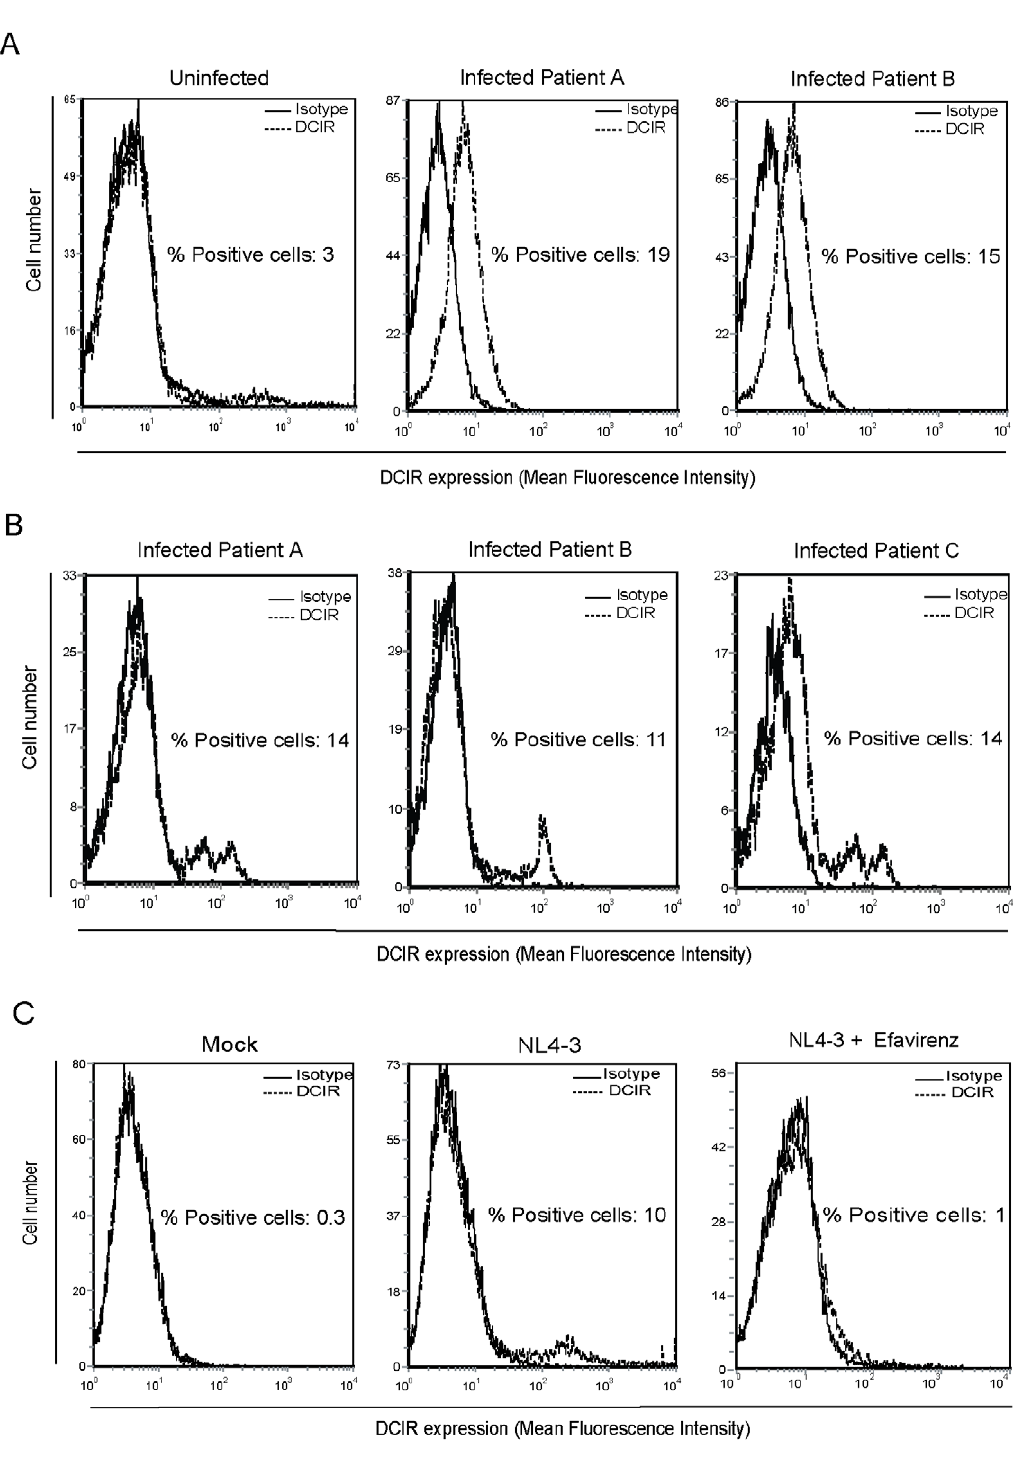
Figure 1. HIV-1 induces DCIR expression in CD4 + T cells under both invivo and invitro conditions. Purified CD4 + T cells were isolated from uninfected healthy donors and two HIV-1-infected aviremic/treated persons (P , 0.05) (A) or three viremic/treatment-naive patients (P , 0.001) (B). Next, cells (1 6 10 6 ) were stained with the R-PE-labeled anti-DCIR monoclonal Ab. Expression of DCIR is shown as a dotted line, whereas the continuous line represents staining obtained with an isotype-matched irrelevant control Ab. For uninfected healthy donors, data shown correspond to a single experiment representative of 5 distinct donors. (C) Purified human primary CD4 + T cells (1 6 10 6 ) were pulsed or not with NL4-3 (100 ng of p24). Three days later, DCIR expression was evaluated by flow cytometric analysis through the use of a R-PE-labeled anti-DCIR monoclonal Ab. Expression of DCIR is shown as a dotted line, whereas the continuous line represents results obtained with an isotype-matched irrelevant control Ab. Data shown in panel C correspond to a single experiment representative of 3 independent experiments (P , 0.01). Statistical analyses were made by comparing fluorescence intensities in samples from HIV-1-infected patients or NL4-3-infected cells and the isotype-matched irrelevant control Ab.